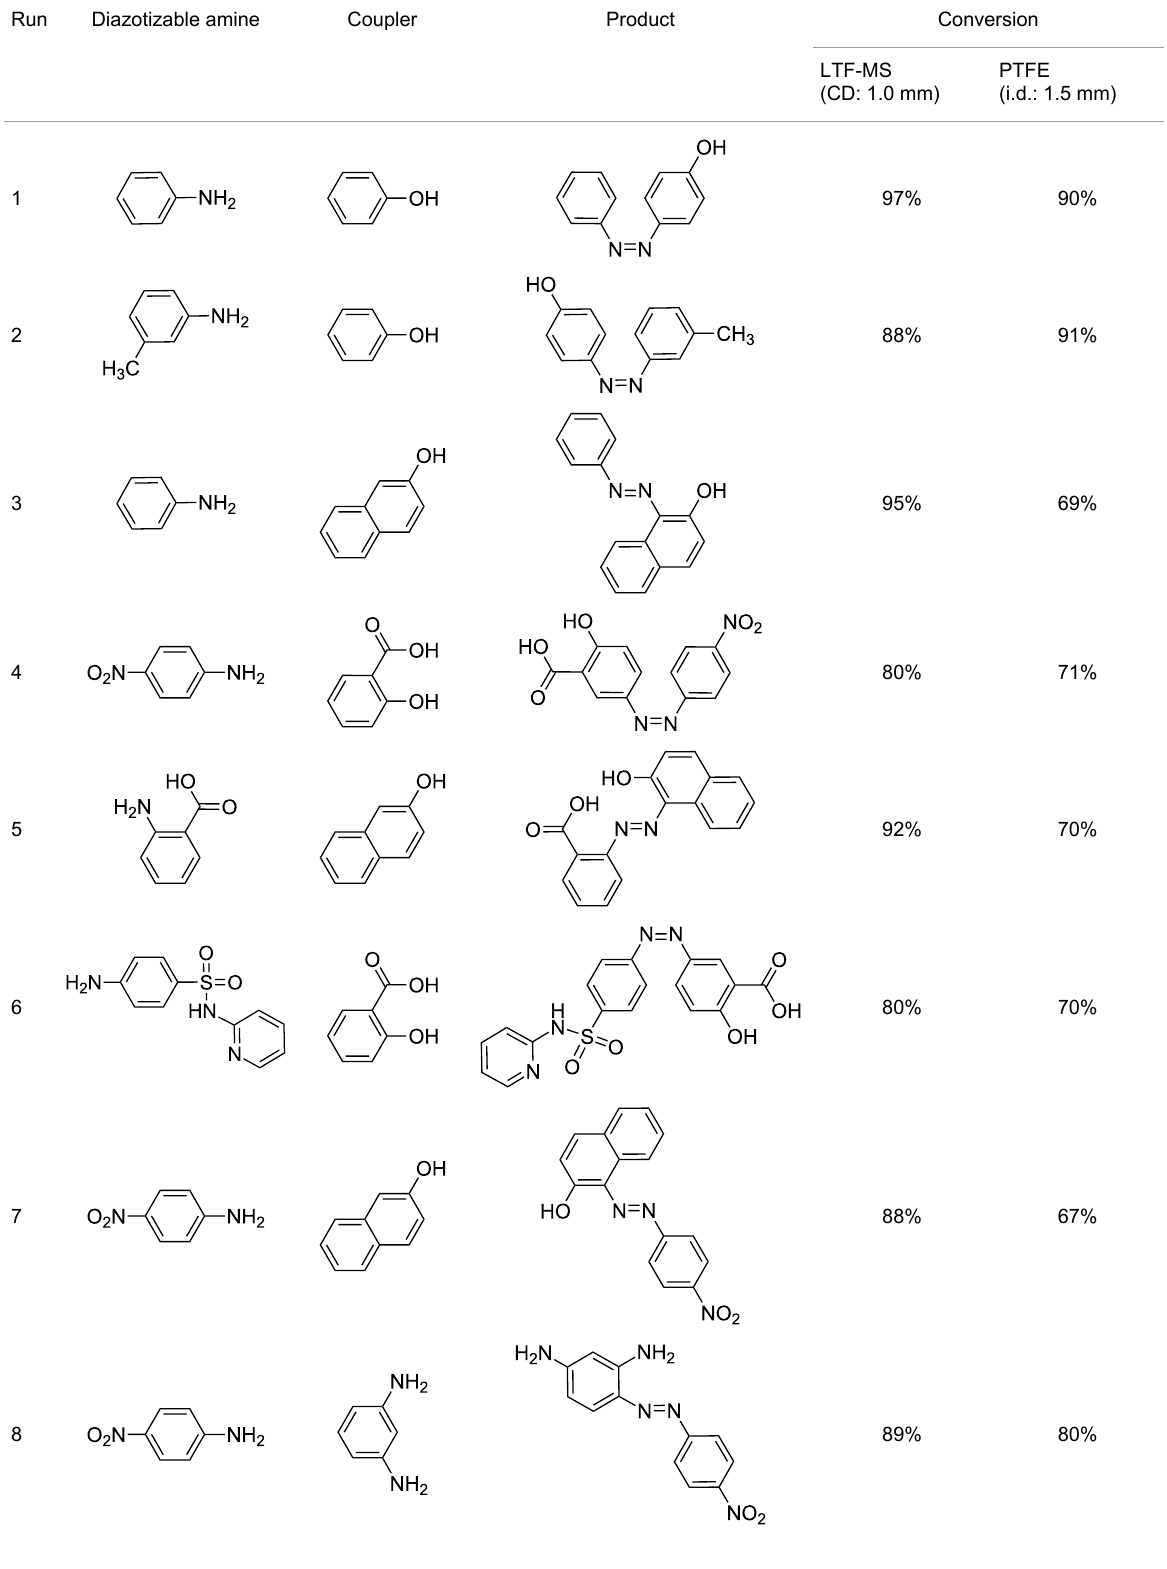
Table 8: Comparison of reaction conversion attained from two continuous flow reactor systems.